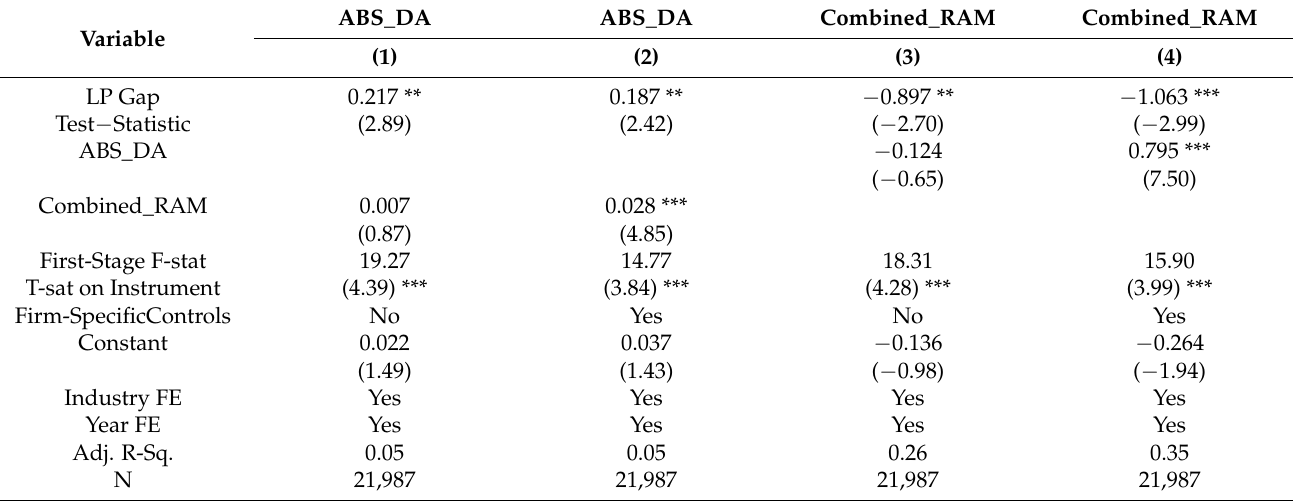
Table 6. Results from the instrumental variable analysis. (** indicates level of significance at 95% level and *** indicates level of significance at 99%